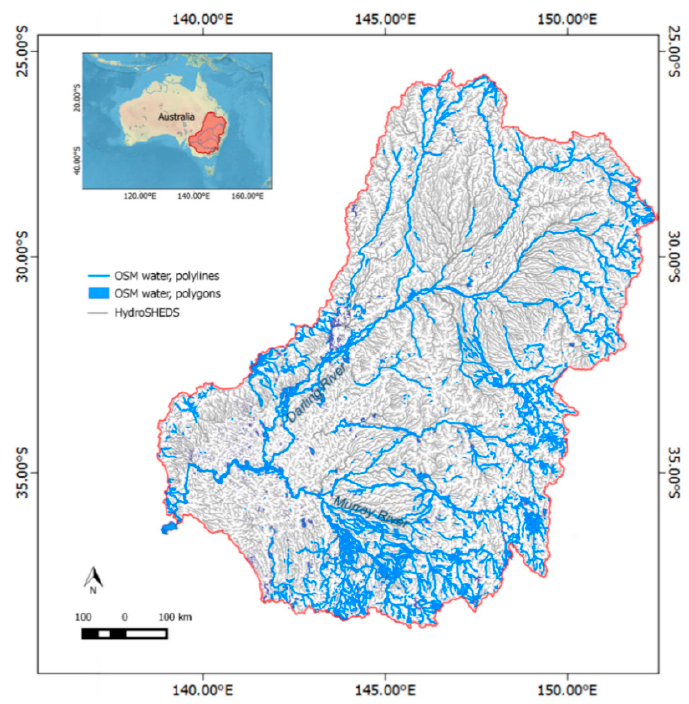
Figure 1. Overview of the study area, Murray-Darling River Basin, and vector water mask dataset extracted from OSM. The inset map is based on Natural Earth 1 raster dataset [38].